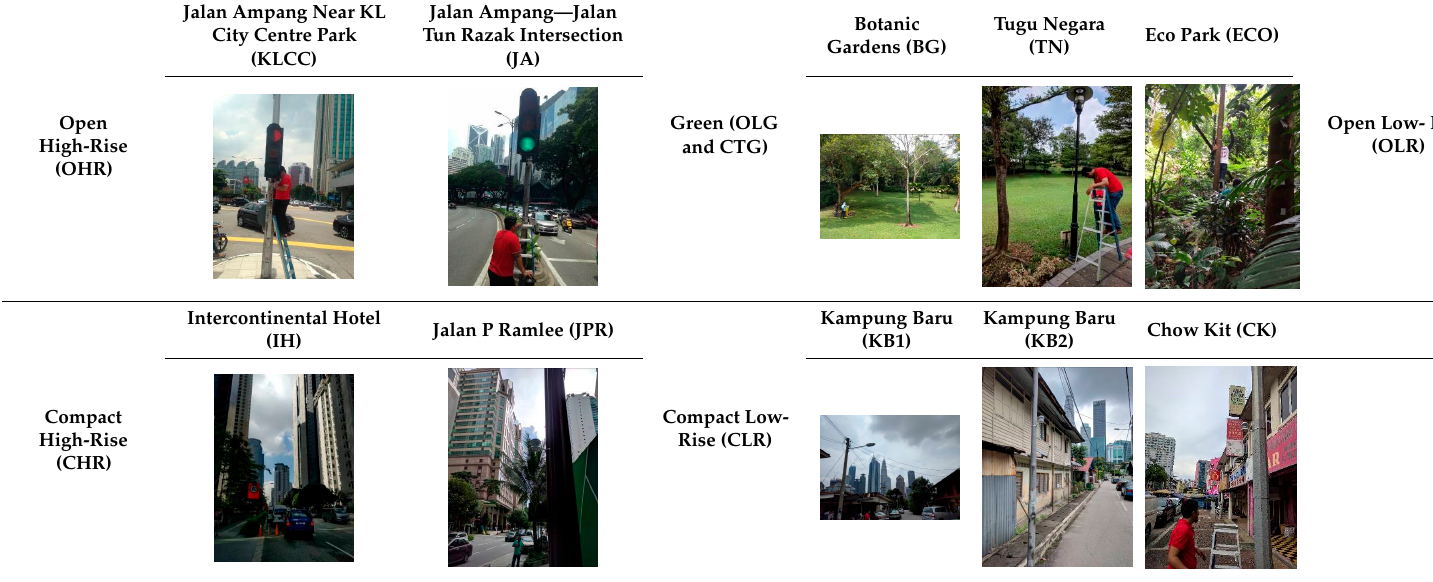
Open Open Open High- High-